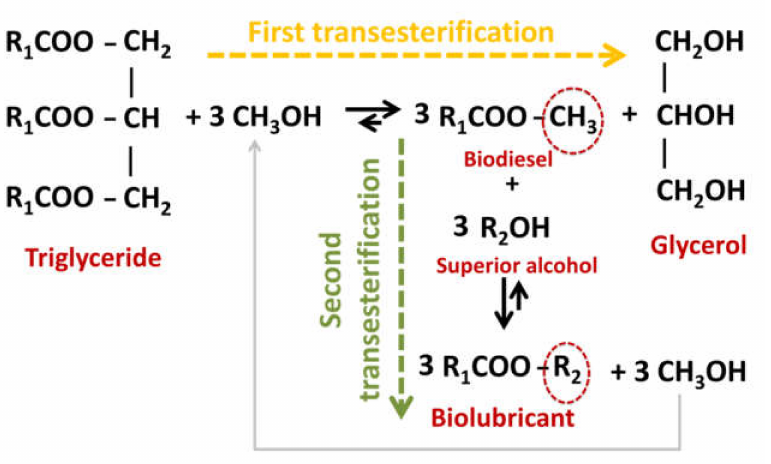
Figure 1. Double transesterification for biolubricant production. R 1 = alkyl group of fatty acids. R 2 = alkyl group of the superior